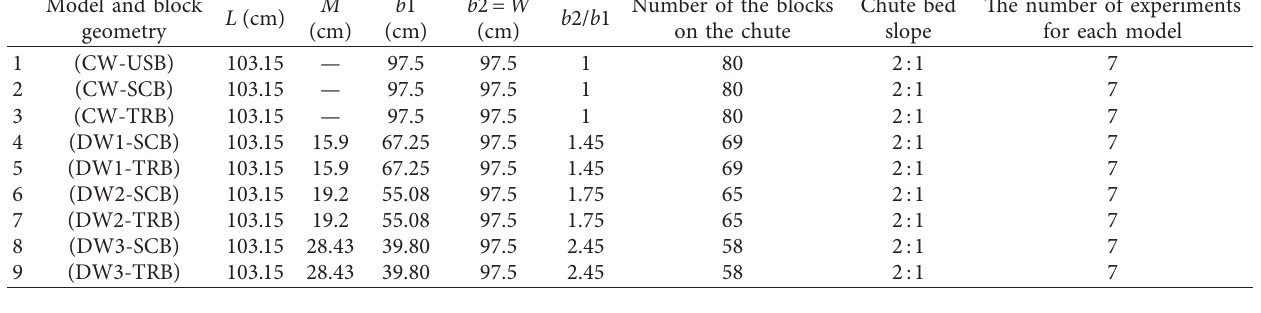
Table 1: Dimensions and characteristics of the models constructed on the chute tested in the laboratory. Model and block